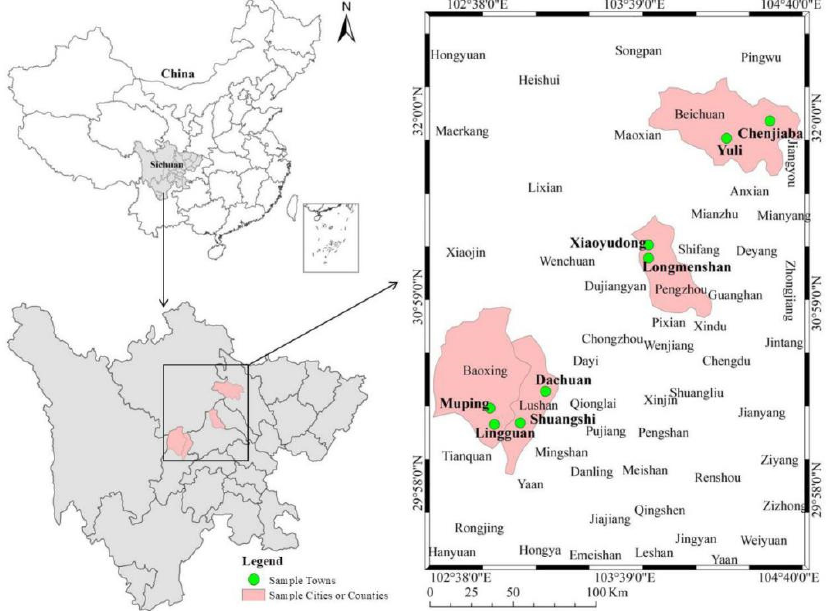
Figure 1. Location map of sample counties and towns. (Source: National Natural Science Foundation of China project, 2019).